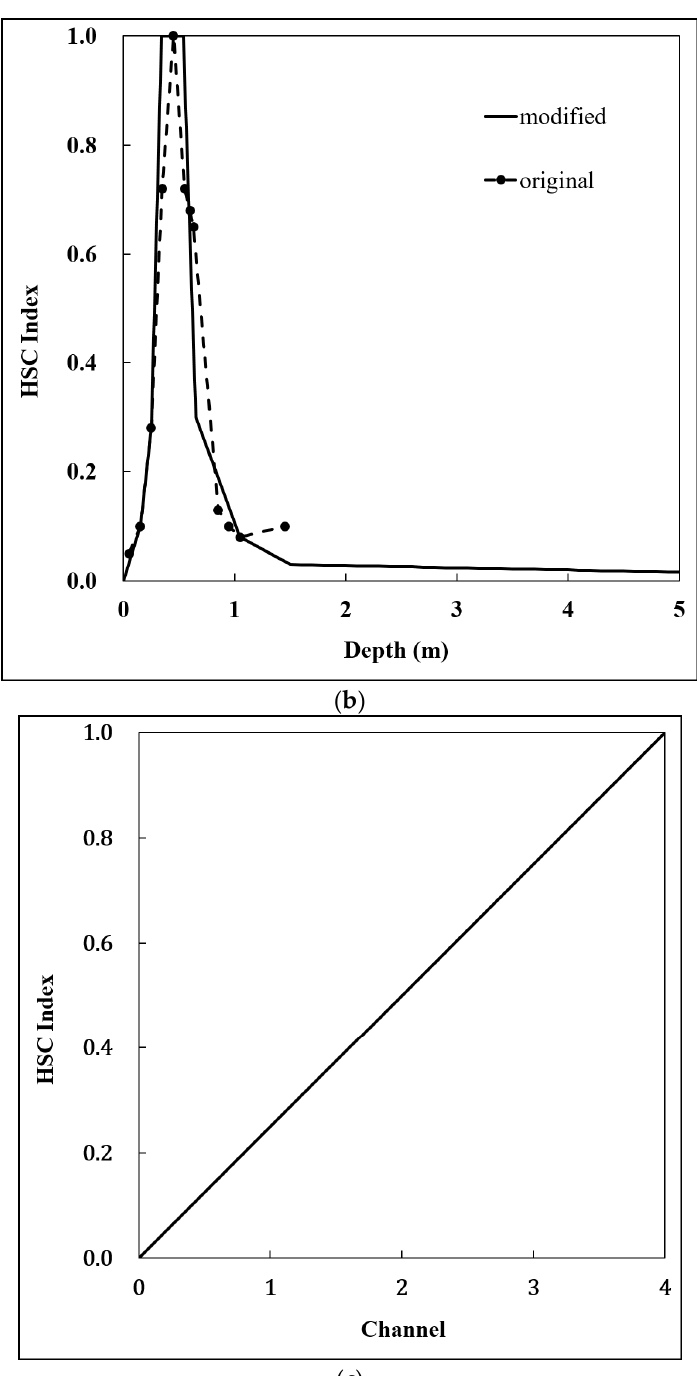
Figure 8. HSC indices for ( a ) velocity; ( b ) depth; ( c ) Channel Index.